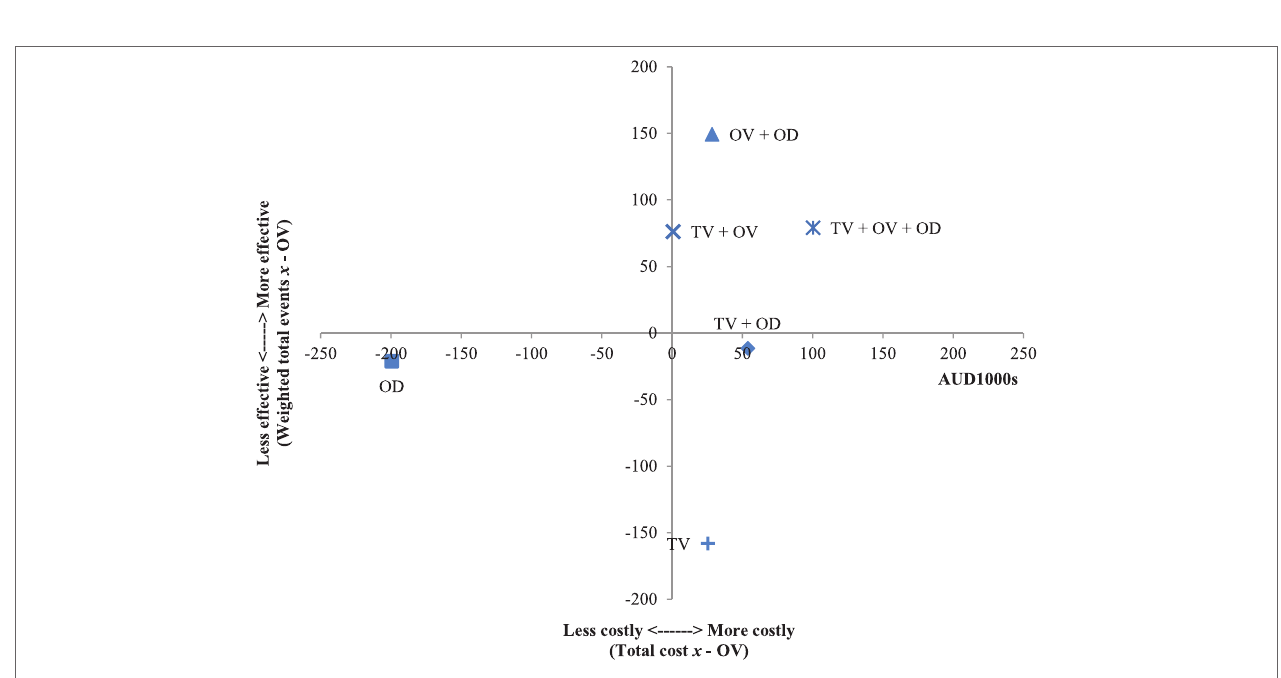
FiguRE 2 | Incremental cost-effectiveness of each format compared with online video (OV). The cost-effectiveness of OV forms the baseline (cross-section of x and y axes). Effectiveness is weighted total events of each format ( x ) compared with OV. Cost is total costs in AUD1,000s of each format ( x ) compared with OV. Data points that fall in the upper left quadrant represent formats that are more cost-effective than